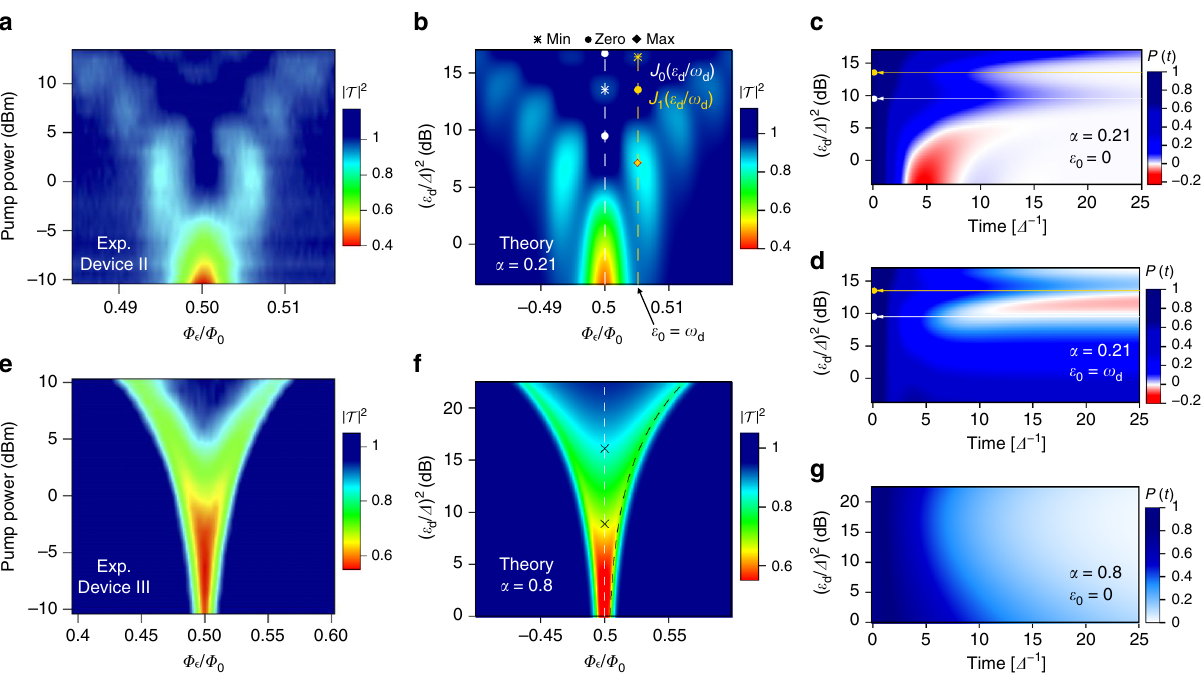
Fig. 3 Spectral response and dynamics of the driven spin-boson system. a , b Observed and calculated transmission at the probe frequency for the moderately coupled Device II ( α = 0.21) as function of static bias and pump strength. A clear structure of multi-photon resonances appears. The dashed lines indicate cuts at fi xed bias where the dynamics in panels c , d are calculated. c , d Predicted dynamics of P ( t ) with P (0) = 1. e , f Observed and calculated spectrum of the ultrastrongly coupled Device III (with α = 0.8). The spectrum is smoothed, as compared to panels a , b , indicating fully incoherent dynamics. The black dashed line in f corresponds to the condition ε eff = 2 k B T / ħ for the effective nonequilibrium bias (see Eq. (7)) and the symbols “ × ” mark the fi rst two zeroes of J 0 ( ε d τ env ). g Time evolution of P ( t ) calculated at the symmetry point, ε 0 = 0, in the same range of pump strengths as in panel maximum in χ ″ ( ω p ) corresponds to a minimum in the trans- amplitude ε p and frequency ω p , and the drive (d), with amplitude ε ω mission T ð ω p Þ . By recording the evolution of the transmission as d and frequency d . For details, see the Methods section. The a function of ω p and of another external parameter, e.g., the static asymmetry ε 0 , various dynamical regimes can be identi fi ed. Fig. 2d – f as a function of the applied static bias ε 0 for the three values of α discussed above. As expected, the qubit dispersion relation can be traced back in the highly coherent and under- damped regimes corresponding to α = 0.007 and α = 0.21, respectively. In the overdamped regime, with α = 0.8, the transmission is nearly independent of ω p . Finally, comparison with the measured transmission for three distinct tunable devices, named I, II, and III in the following, allows us to position the three devices as shown in the phase diagram in Fig. 1c.